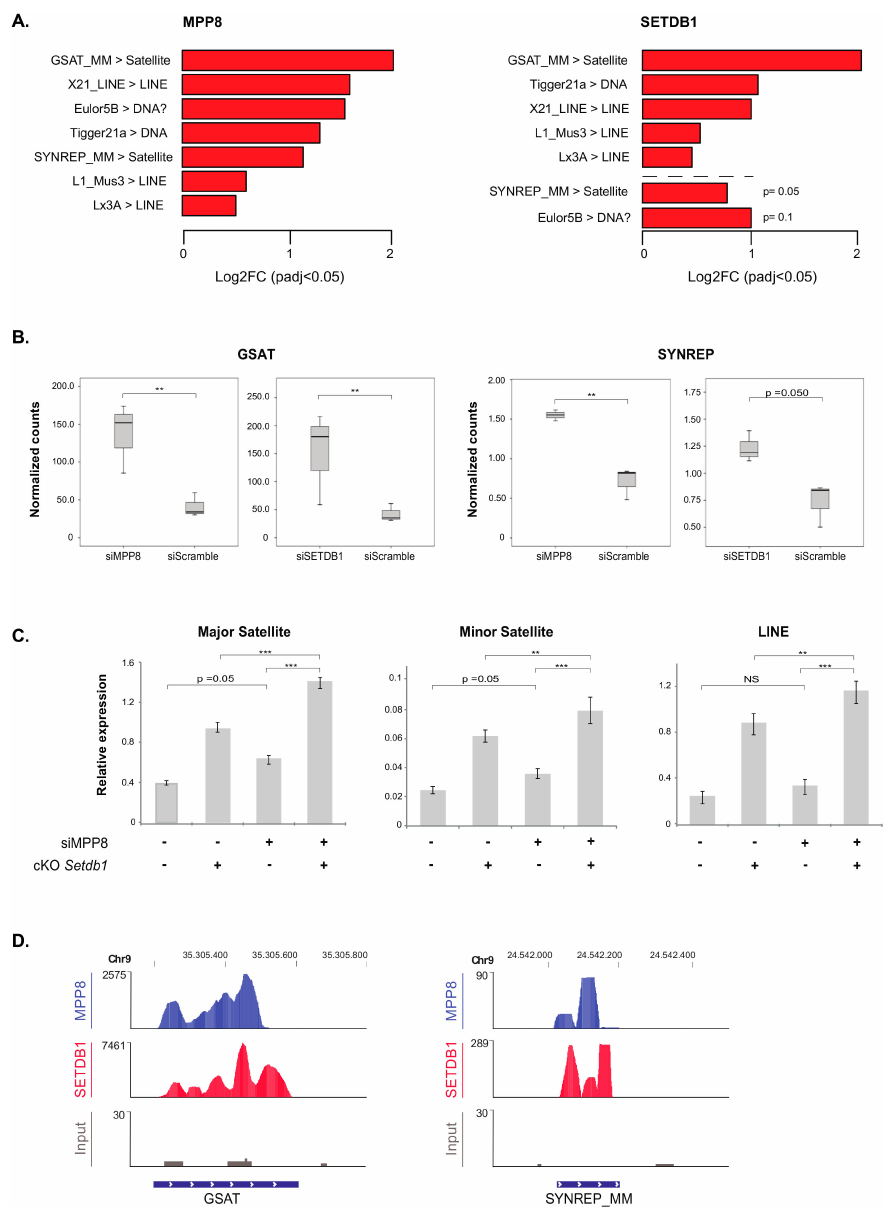
Figure 4. The major and minor satellites are de-repressed upon acute MPP8 or SETDB1 loss-of-function in mESCs. ( A ) Left panel: RNA-seq data showing the di ff erential expression of repeated elements (Log2FC > 1; p -value < 0.05) in HM1 mESCS upon siRNA-mediated acute KD of MPP8 and control. Right panel: Corresponding up-regulated repeated elements ( p -value < 0.05) in HM1 mESCS upon siRNA-mediated acute KD of SETDB1 and Scramble treatment. Note that SYNREP and Eulor5B sequences had p -value > 0.05. Red bars indicate upregulated repeated elements. ( B ) Barplot representation of normalized counts from RNA-seq data of the satellites GSAT and SYNREP in mESCs upon MPP8 or SETDB1 KD. n = 3 biological replicates ** p < 0.05. ( C ) RT-qPCR analysis of major and minor satellites sequences, as well as LINE repeats, in mESCs upon MPP8 KD and / or Setdb1 KO (cKO). mRNA levels were normalized to GAPDH or Cyclophilin A mRNA. For statistical significance, Student t-tests were applied to data following normal distribution, otherwise, Mann–Whitney’s unpaired tests were applied. (n = 3 biological replicates) ** p < 0.05 or *** p < 0.01. ( D ) Genome browser representation including tracks for MPP8 ChIP-seq and SETDB1 ChIP-seq in mESCs at GSAT and SYNREP satellites. Repeats data was retrieved from Repeat Masker via UCSC genome